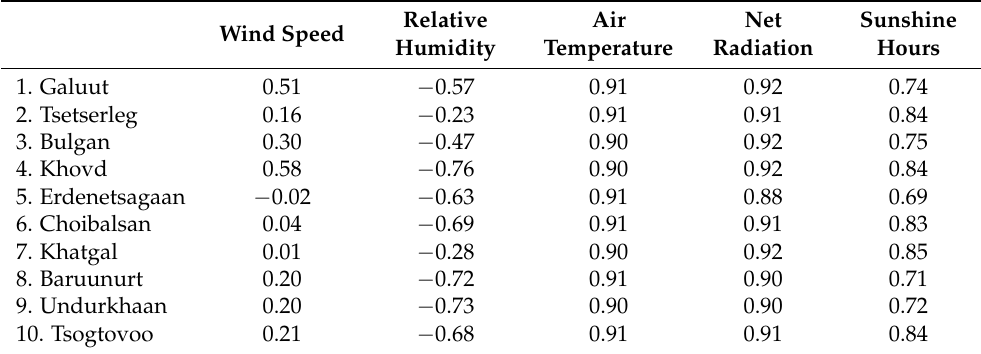
Table 3. Pearson correlation coefficients between FAO-56 PM daily ET 0 and meteorological variables over the 10 weather stations in